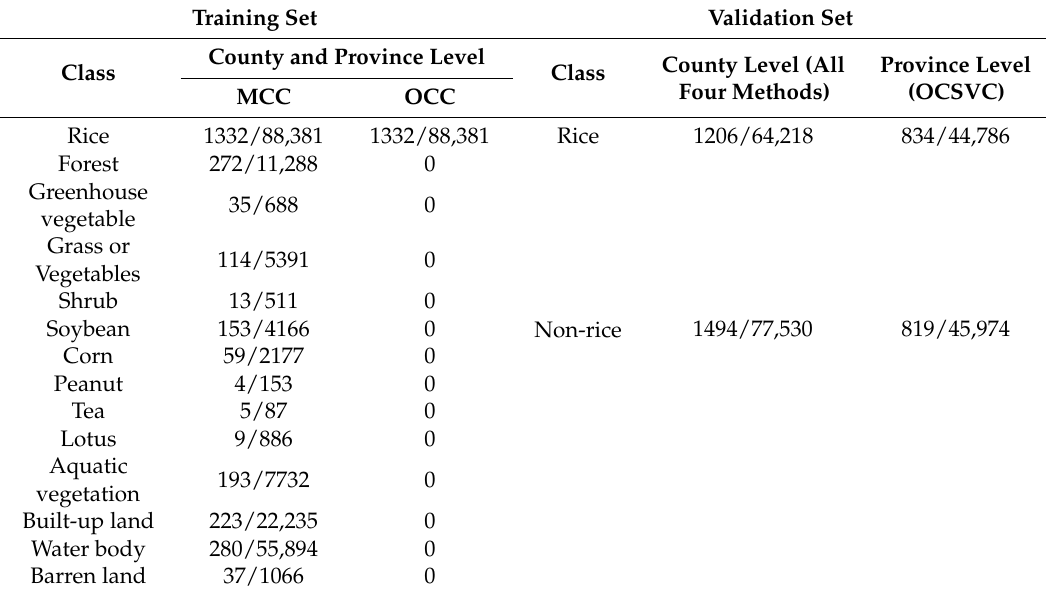
Table 4. Training and validation samples (represented by POI/pixel number) used in this study. Training Set Validation